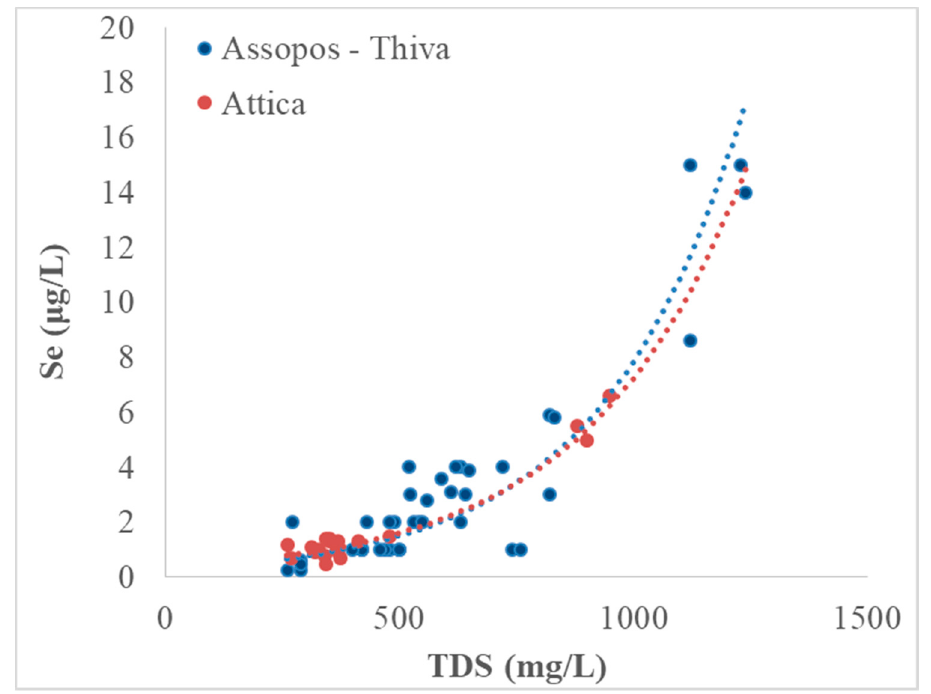
Figure 6. Plot of the Se versus total dissolved solids (TDS) concentrations for coastal groundwater from the Assopos-Thiva basin and karst type from Attica. Data from [17–23,30,33].